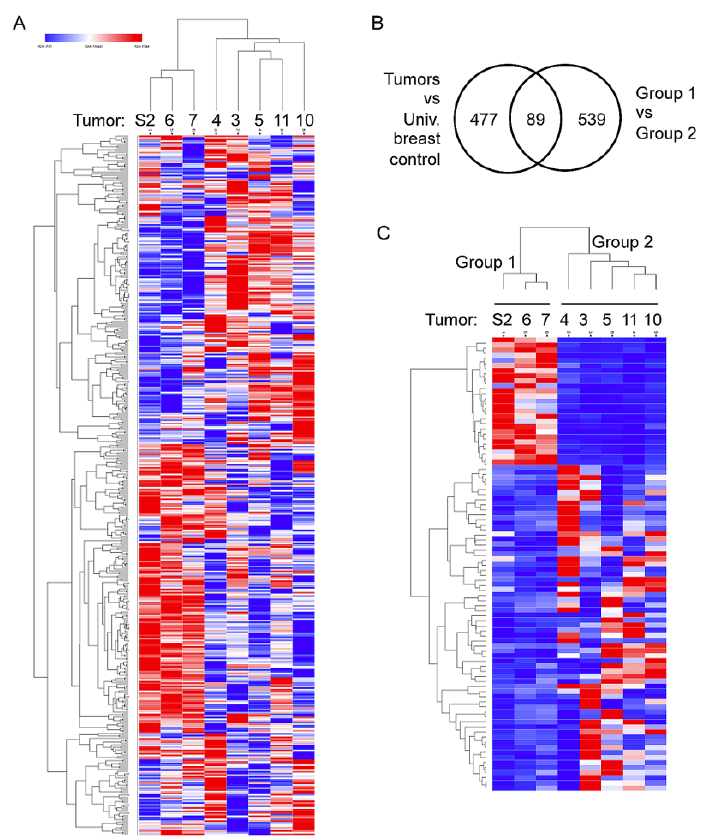
Figure 2. Two distinct groups of tumors based on di ff erential expression clustering of the RNAseq data. ( A ), Heat map of unsupervised clustering; the first node in a hierarchical dendrogram separates S2, S6, and S7 tumors (Group 1) from S3, S4, S5, S10, and S11 tumors (Group 2). ( B ) Venn diagram showing 89 genes commonly found among the di ff erentially expressed gene lists comparing between tumors vs. universal breast control and Group 1 vs. Group 2 tumors. ( C ) Heat map of supervised clustering of tumor using the 89 genes (genes listed in Table